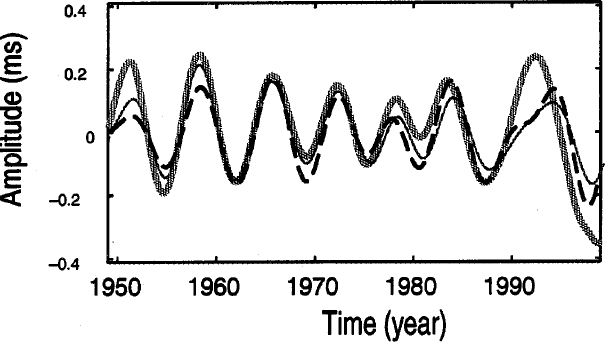
Fig. 3. Six-seven-year oscillation, obtained from a singular spectrum analysis (SSA) with an embedding dimension of 8 years ( bold grey line ). From a wavelet-based filter, 5.5 to 9 years on LOD ( bold dashed line ) and LOD-AAM di(cid:128)erence ( solid line )